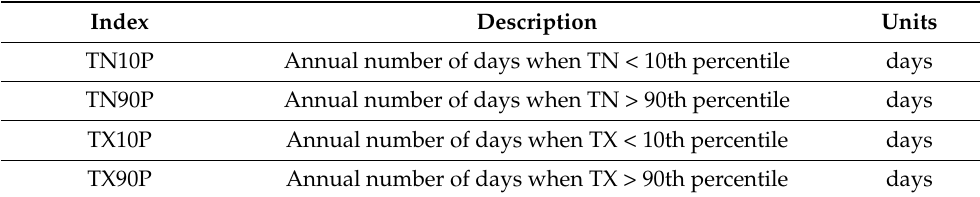
Table 1. List of relevant ETCCDI indices utilized in this study.